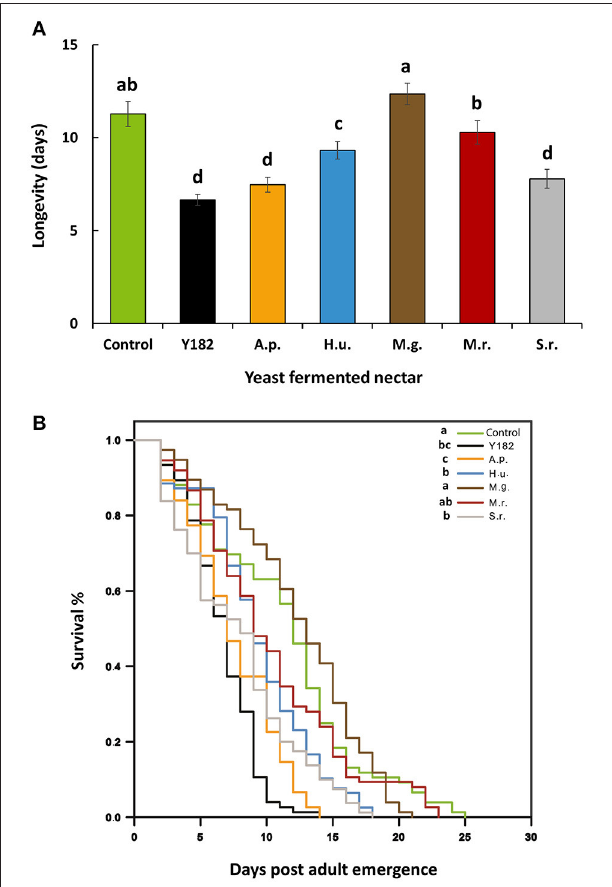
FIGURE 4 | (A) Mean longevity ( ± SE, n = 75, equally distributed over 5 containers) and (B) Kaplan–Meier survival curves of Aphidius ervi adults fed on different nectars, including: Control, non-inoculated, yeast free nectar; Y182, nectar fermented with the reference strain Saccharomyces cerevisiae Y182; A.p., Aureobasidium pullulans -fermented nectar; H.u., Hanseniaspora uvarum -fermented nectar; M.g., Metschnikowia gruessii -fermented nectar; M.r., Metschnikowia reukaufii -fermented nectar; S.r., Sporobolomyces roseus -fermented nectar. Experiments were performed with cell-free